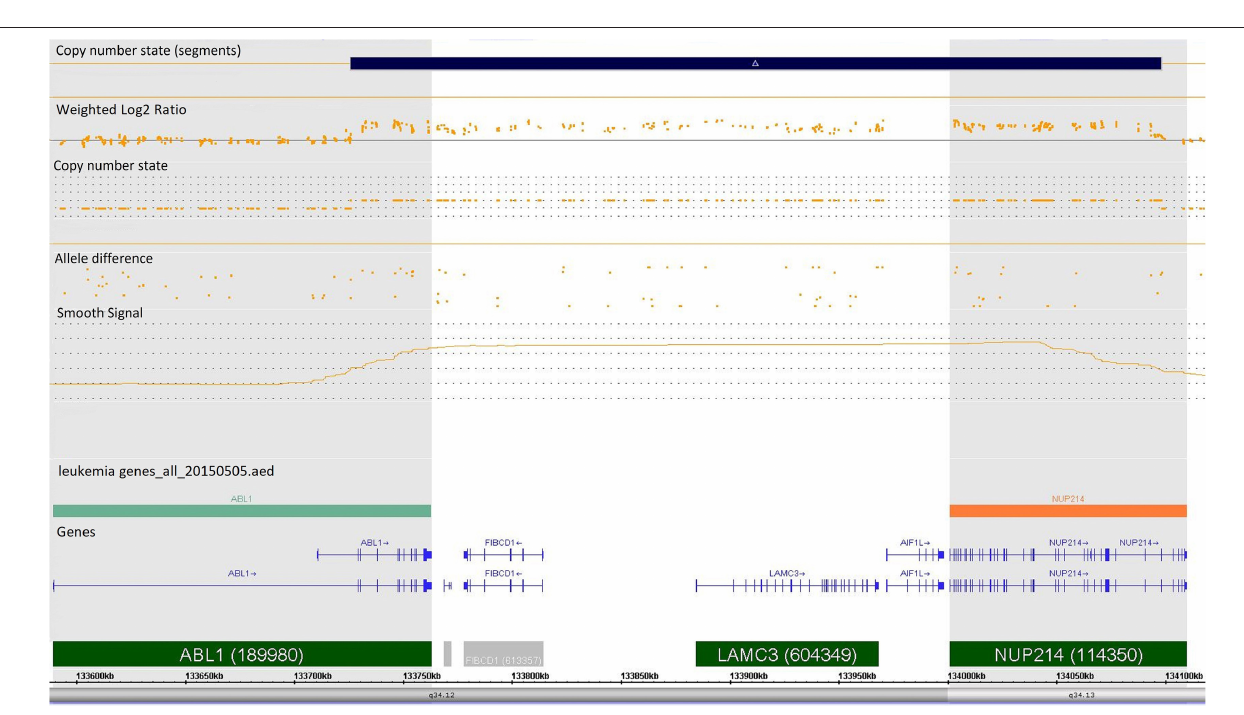
FIGURE 3 | Single-nucleotide polymorphism (SNP) array of the amplification in 9q34 was limited by NUP214 (from exon 1 to exon 31) and ABL1 (from exon 2 to the 5 ′ end of the gene). Colored segmental region (top line: blue color—gains), copy number state allele difference, and smooth signal (bottom panel) aberrations by SNP